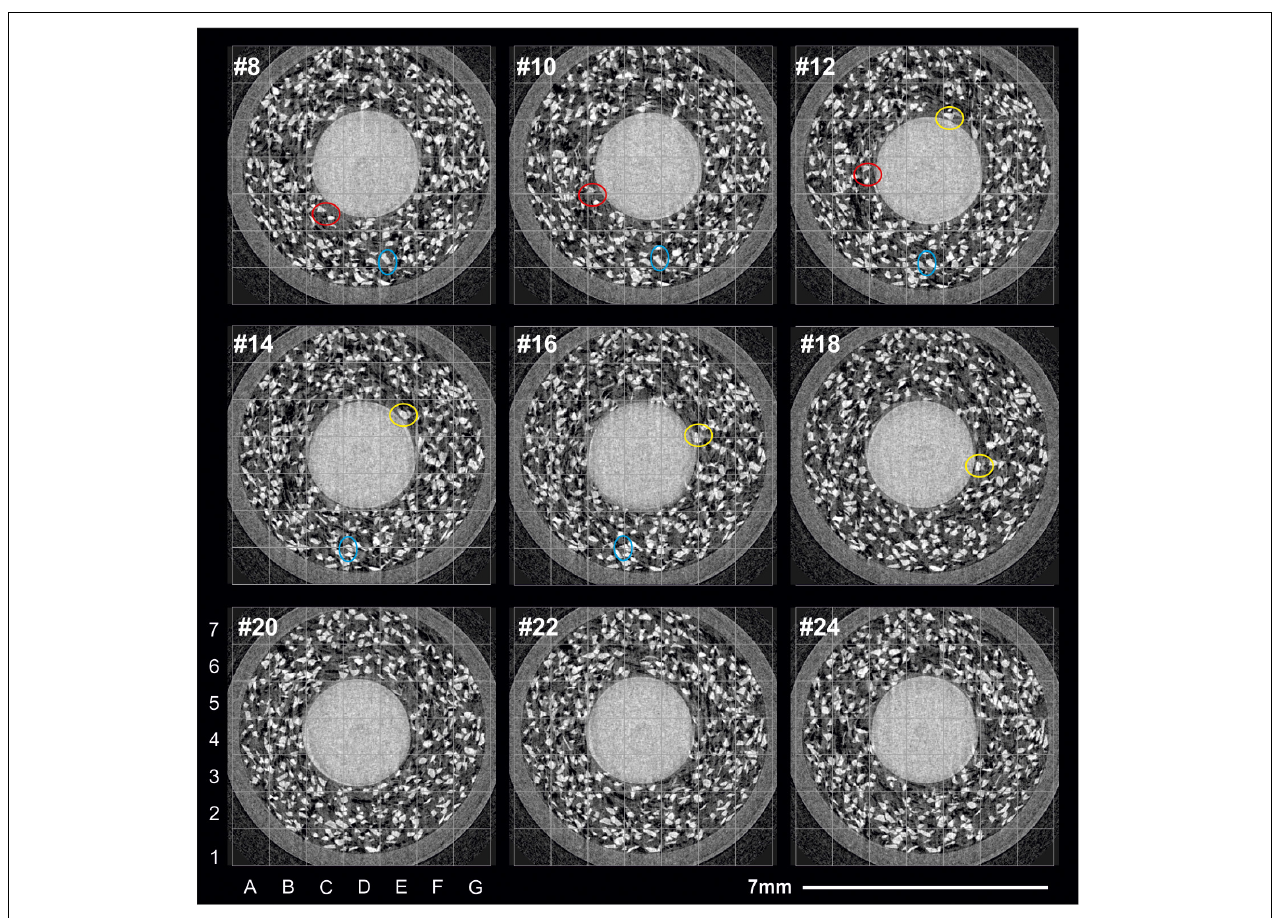
FIGURE 9 | Two-dimensional grayscale slices perpendicular to the rotation axis showing the deformation and coalescence in a selection of slices through a low temperature analog system. N2700000 + 30% by volume olivine crystals. See text for discussion. The red, yellow and blue circles show examples of specific crystals and crystal clusters that can be tracked between frames. Note that rotation of crystals and translation out of the plane of the image makes 2D only tracking